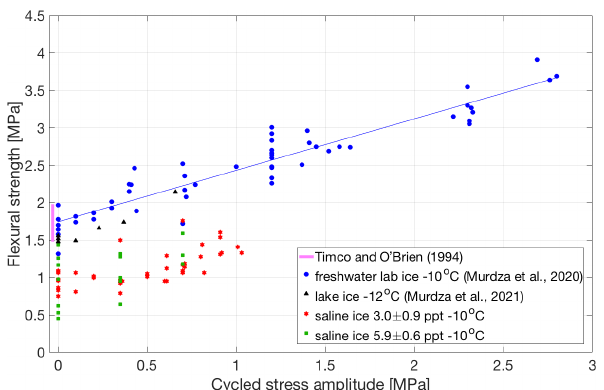
Figure 10. Flexural strength as a function of position of saline ice samples of higher salinity (5.9 ± 0.6ppt) for different cyclic ampli- tudes. The imposed number of cycles for specimens cycled at 0.35 and 0.7MPa is ∼